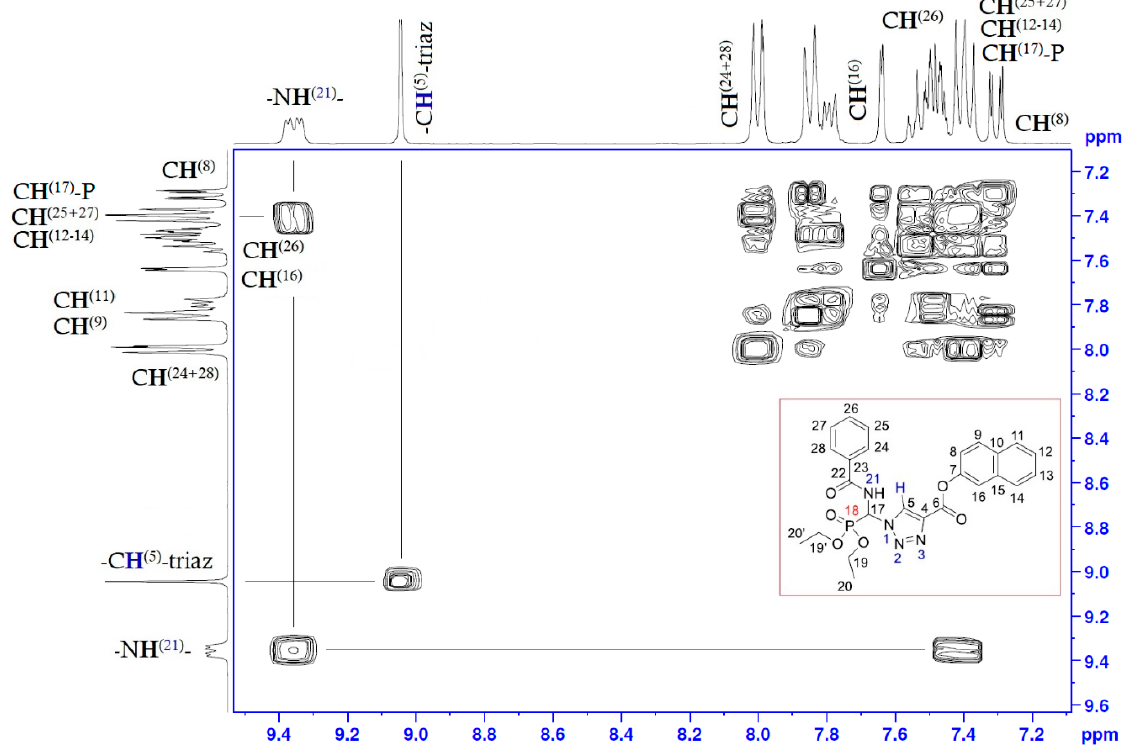
Figure 4. Two-dimensional COSY spectrum of the cycloadduct ( 3 ) ( Aliphatic part ).